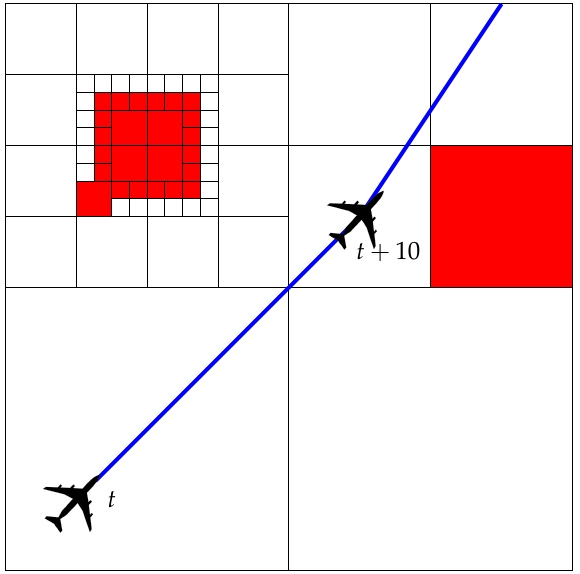
Figure 15. QuadTree around the aircraft